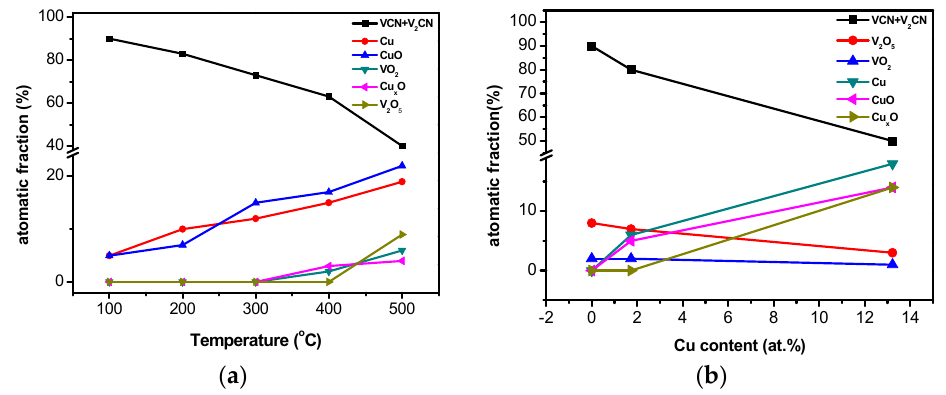
Figure 10. Oxide-content of VCN–13.2 at.% Cu composite films after sliding ( a ) at different temperatures and ( b ) oxide-content of VCN–Cu composite films after sliding at 500 °C.